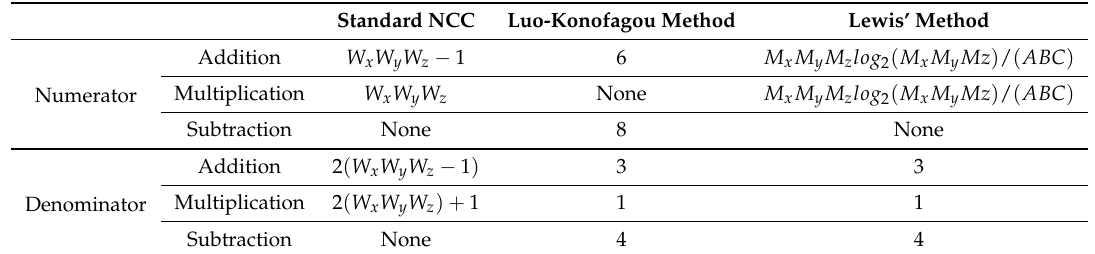
Table A1. A summary of algorithmic complexity for computing a single NCC value under the block-matching algorithm. The costs involving the construction of sum-tables is not included and analyzed below in Table A2.